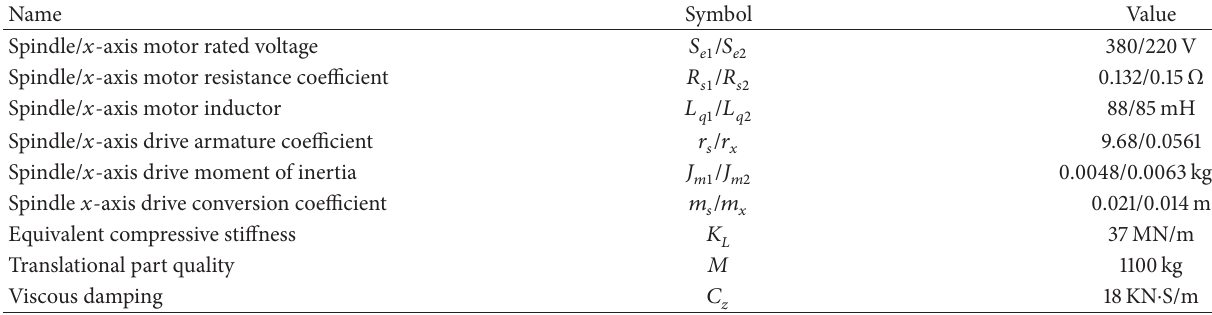
Table 1: Parameters of simulation system model.